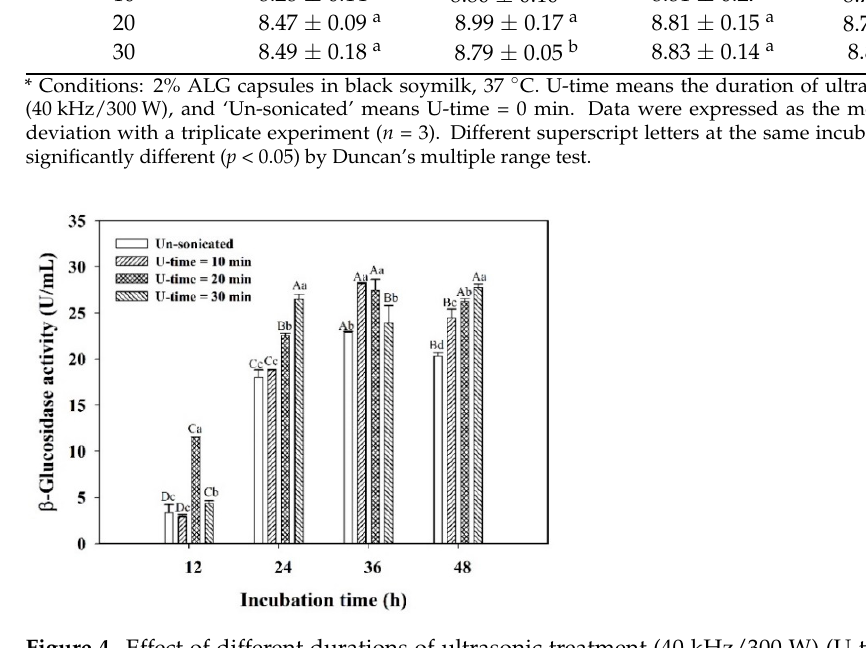
Figure 4. Effect of different durations of ultrasonic treatment (40 kHz/300 W) (U-time) on the β - glucosidase activity of encapsulated L. plantarum BCRC 10357 within 2% ALG capsules in black soymilk at 37 °C. Data were expressed as mean ± standard deviation with triplicate experiment ( n = 3). Values with different lowercase letters at the same incubation time and different uppercase letters at the same U-time were significantly different ( p < 0.05) by Duncan’s multiple range